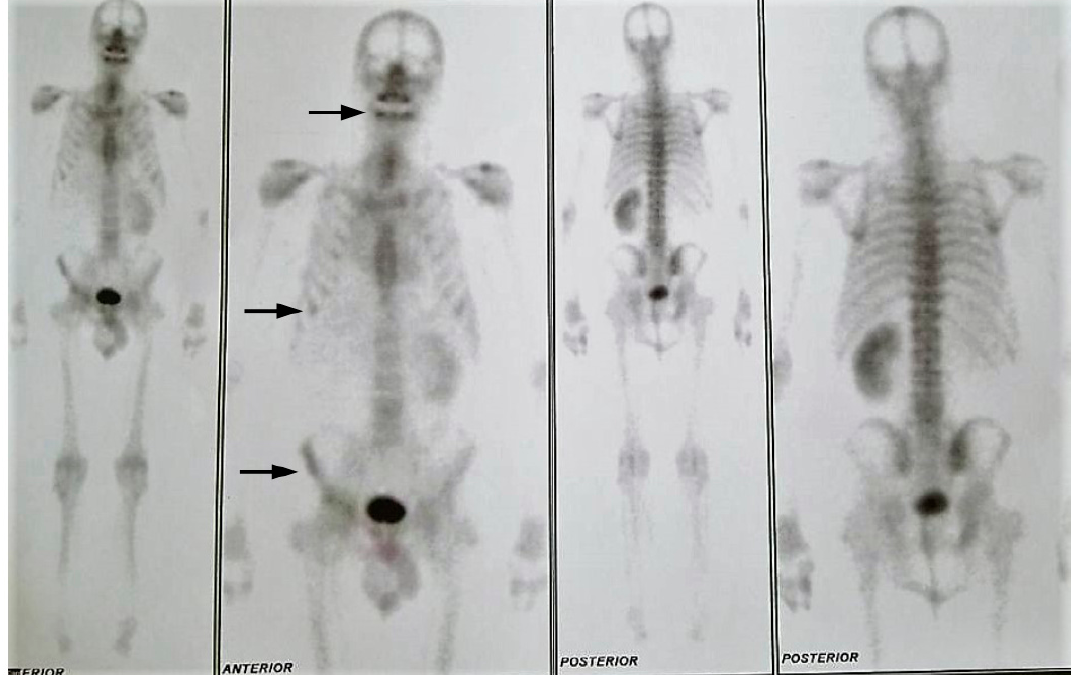
Figure 9. Year 2018: Front view: rib metastasis, iliac bone metastasis, increased radionuclide caption at maxillary alveolar level. Stable disease.